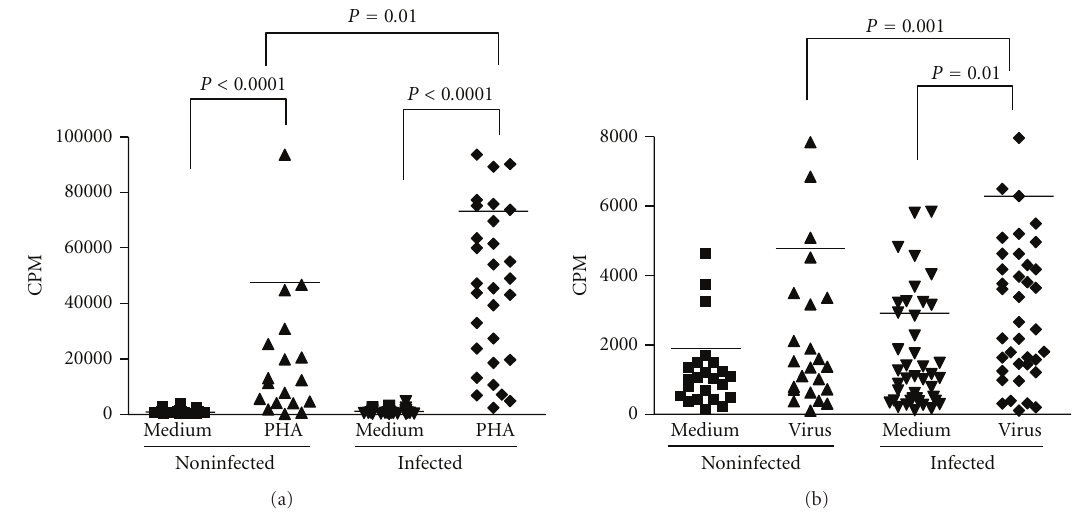
Figure 2: Proliferative responses in PBMCs of individuals infected or not by zoonotic Vaccinia virus. Peripheral blood mononuclear cells (PBMCs) from patients infected or not with zoonotic Vaccinia virus were cultured in the presence of PHA (a), UV-inactivated virus (b) or mock-treated (medium). After 6 days of stimulus, the cell proliferation was determined by [ 3 H]thymidine incorporation. Statistical significance ( P values), based on the median values of each group, is presented on the graphs. CPM: counts per minute. Table 1: Mean percentage of T (CD3 + , CD4 + , CD8 + ) and B (CD19 + ) lymphocytes, NK cells (CD16 + ) and monocytes (CD14 + ) on PBMCs from noninfected or zoonotic Vaccinia virus infected individuals after stimulation with virus antigens. Cell phenotype